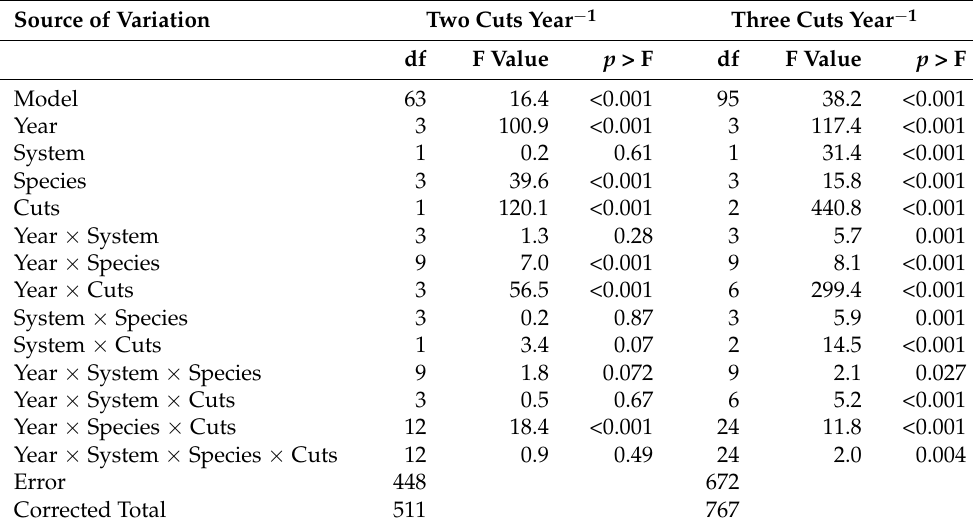
Table 3. The ANOVA F and p values for the main and interaction effects of year, harvest regime (system), species, and harvest frequency (cuts) on two- and three-cut forage systems for two-year- old NWSG stands recorded from 2014 to